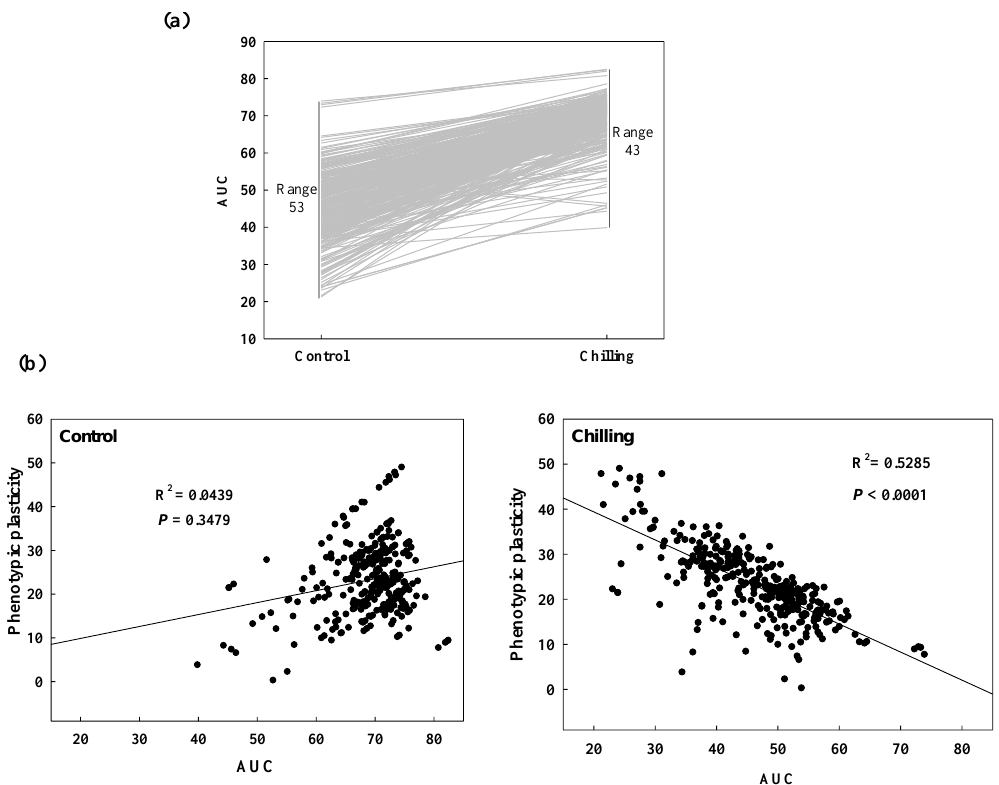
Figure 4. Studies of phenotypic plasticity. (a) Reaction norms for AUC with or without moist-chilling treatment across the 83 populations; (b) relationship between phenotypic plasticity and AUC with or without moist-chilling treatment. Best fit lines based on linear models are provided.